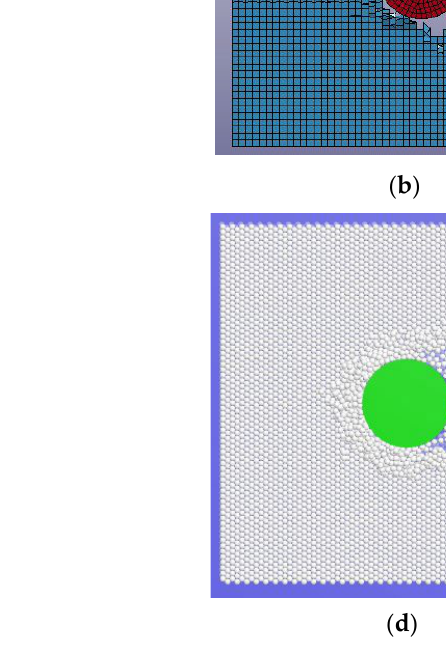
( d ) Figure 6. Simulation of interaction between cone structure and level ice. ( a ) Schematic diagram of finite element method calculation; ( b ) top view of finite element method calculation; ( c ) schematic diagram of discrete element method calculation; ( d ) top view of discrete element method calcula- tion. Figure 7 describes the ice load values under the same ice condition for cylinder and cone structures obtained by different methods. The two simulation methods’ time history curves of ice load show irregular trend fluctuation, and the peak value appears almost simultaneously. The difference is that the peak value of the ice loads obtained by the finite